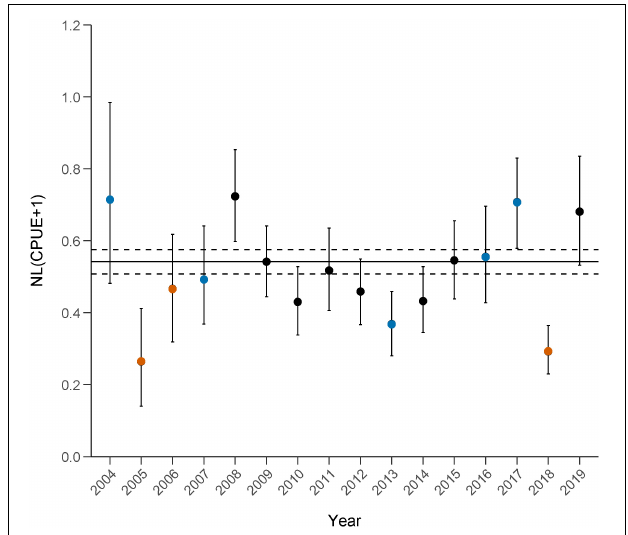
FIGURE 8 | Standardized catch per unit effort (CPUE; mean ± 95% confidence intervals) of 8 bottlenose dolphin prey species combined (excludes Clupeidae spp.) caught during non-severe bloom periods (horizontal line) and in each survey year (circles) between 2004 and 2019. Overlap of 95% CIs between the non-severe bloom periods (horizontal dotted lines) and the CI of an annual CPUE indicates resistance, i.e., no effect of the bloom event. Resilience, or the recovery period post-bloom, is defined as the number of years between the bloom event and the year in which 95% CI overlap. Symbols: • = severe summer red tide years, • = winter red tide years, • = no known red tide disturbance events.